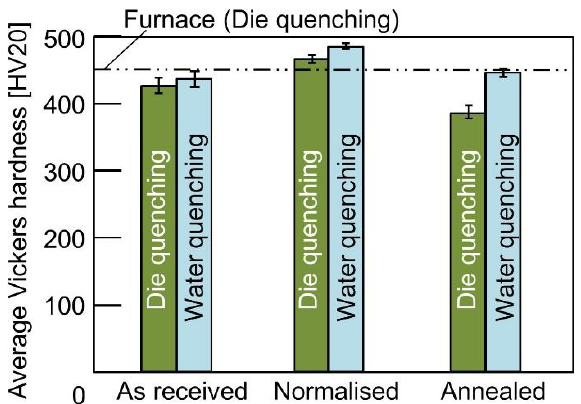
Figure 9. Effect of heat treatment of blank before hot stamping on Vickers hardness after die- and water-quenching using direct resistance heating for v = 275 °C/s and t = 0 s.